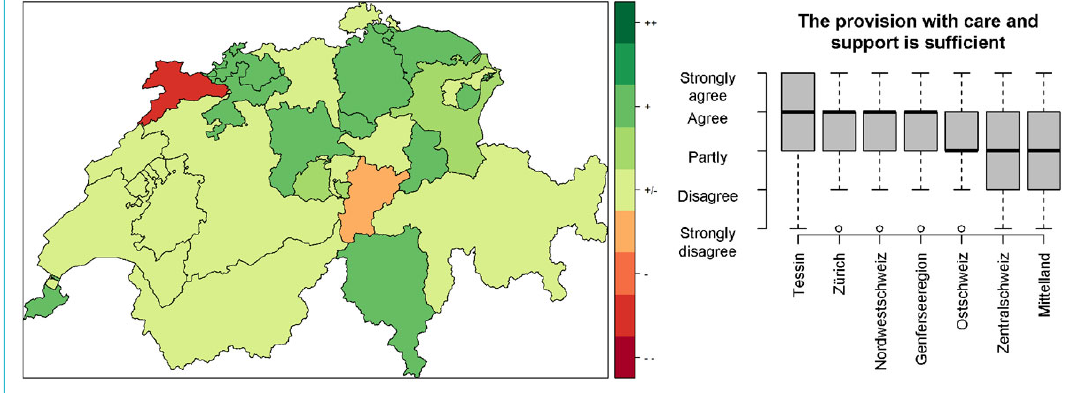
Figure 3: Regional differences in the perception of the provision of care and support facilities. The median across all cantons of Switzerland is presented in the spatial plot (left), and across seven major Swiss regions in the boxplot (right). ++ = strongly agree with sufficient provision of care and support facilities, +/- partially agree, -- strongly disagree with sufficient provision of care and support